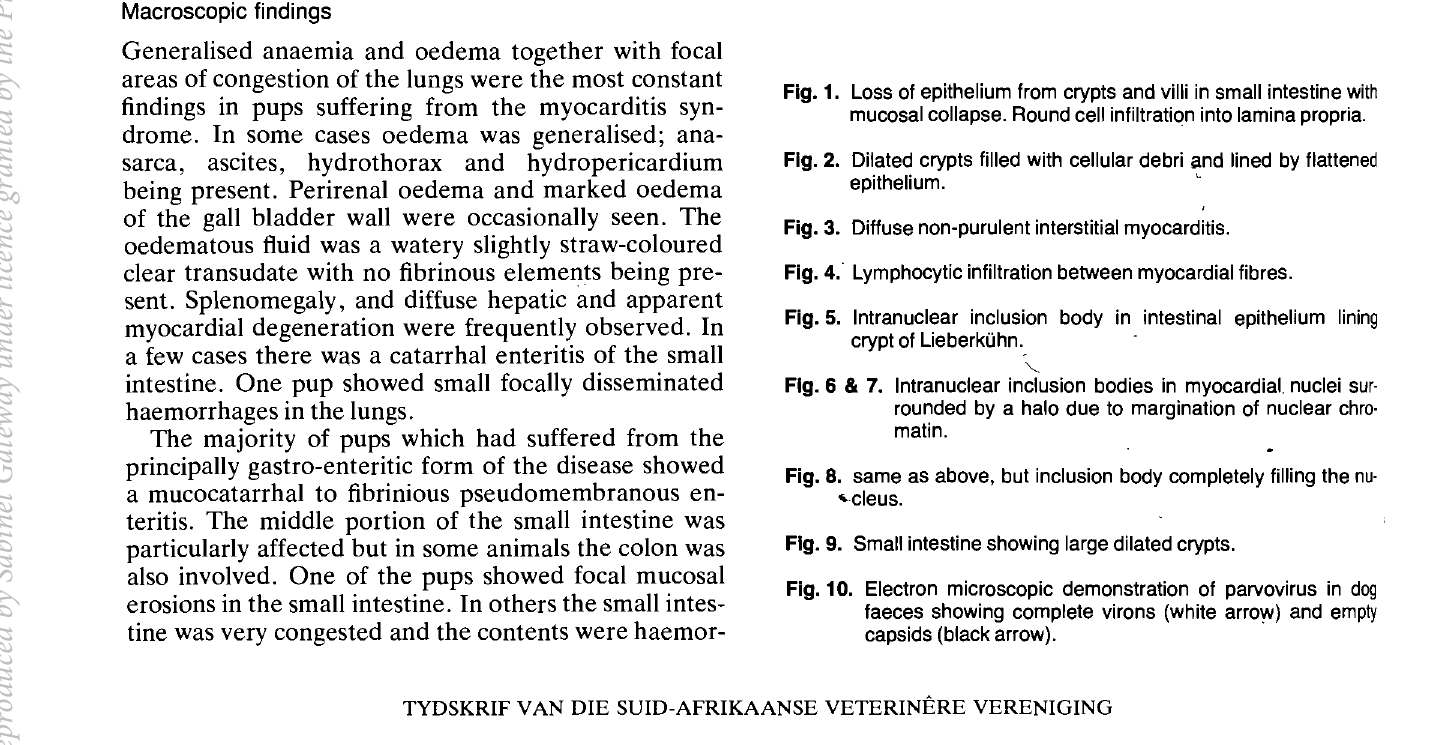
Fig. 1. Loss of epithelium from crypts and villi in small intestine with mucosal collapse. Round cell infiltration into lamina propria. Fig. 2. Dilated crypts filled with cellular debri and lined by flattened epithelium. C Fig. 3. Diffuse non-purulent interstitial myocarditis. Fig. 4." Lymphocytic infiltration between myocardial fibres. Fig. 5. Intranuclear incluSion body in intestinal epithelium lining crypt of LieberkOhn.. . "- Fig. 6 & 7. Intranuclear inclusion bodies in myocardial. nuclei sur· rounded by a halo due to margination of nuclear chro· matin. Fig. 8. same as above, but inclusion body completely filling the nu· 'cleus. Fig. 9. Small intestine showing large dilated crypts. Fig. 10. Electron microscopic demonstration of parvovirus in dog faeces showing complete virons (white arro'!") and empty capsids (black